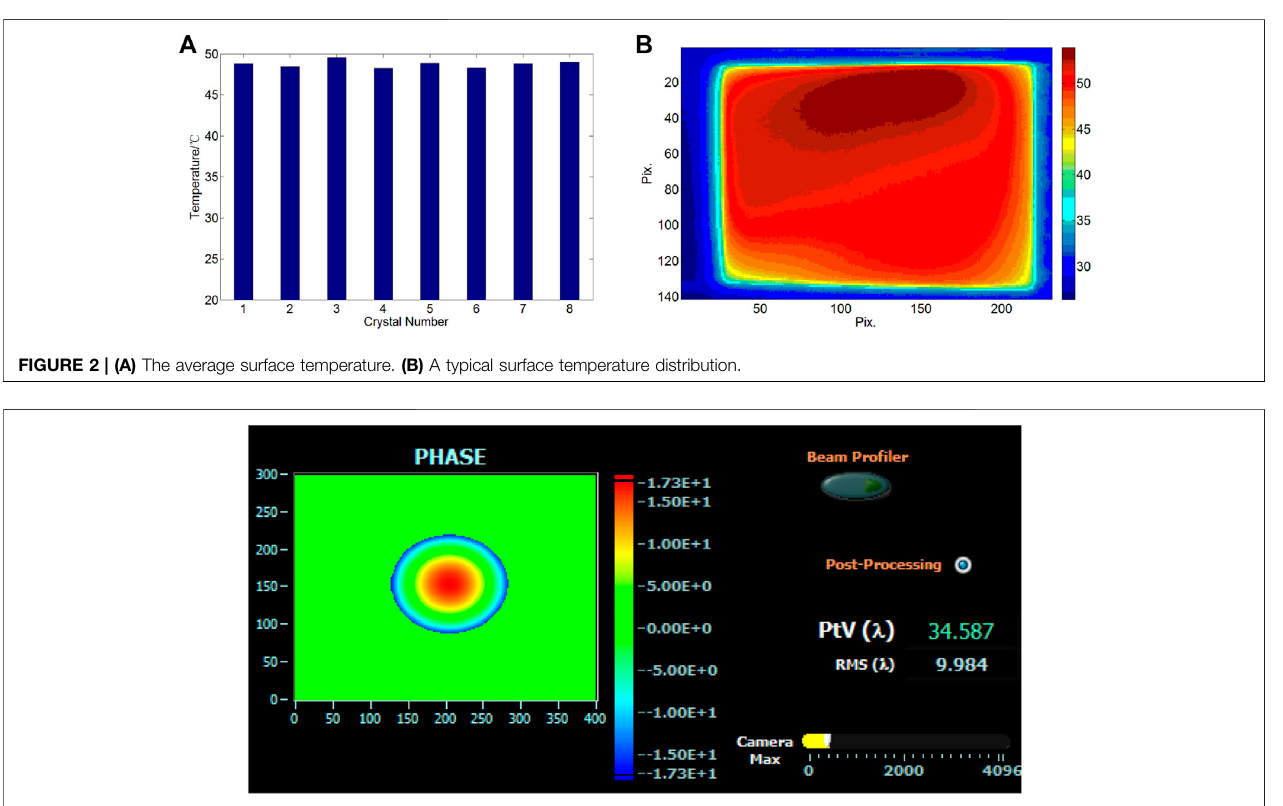
Frontiers in Physics |